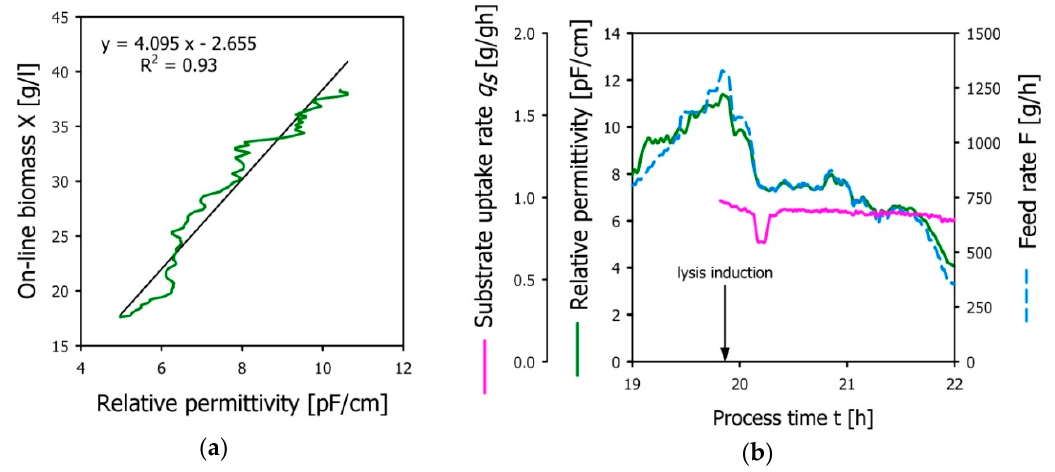
Figure 4. ( a ) Correlation of in-line permittivity measurements with on-line biomass data (transfer function); ( b ) Effective permittivity based feed-rate control. The actual feed-rate (dashed blue line) follows the drop of the permittivity signal (green line) during the E-lysis process and provides a constant specific substrate uptake (pink line).